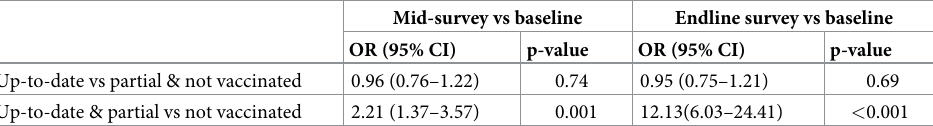
Table 4. Estimated Impact of the